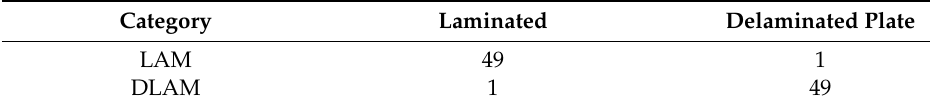
Table 8. Confusion matrix for decision tree with experimental data.